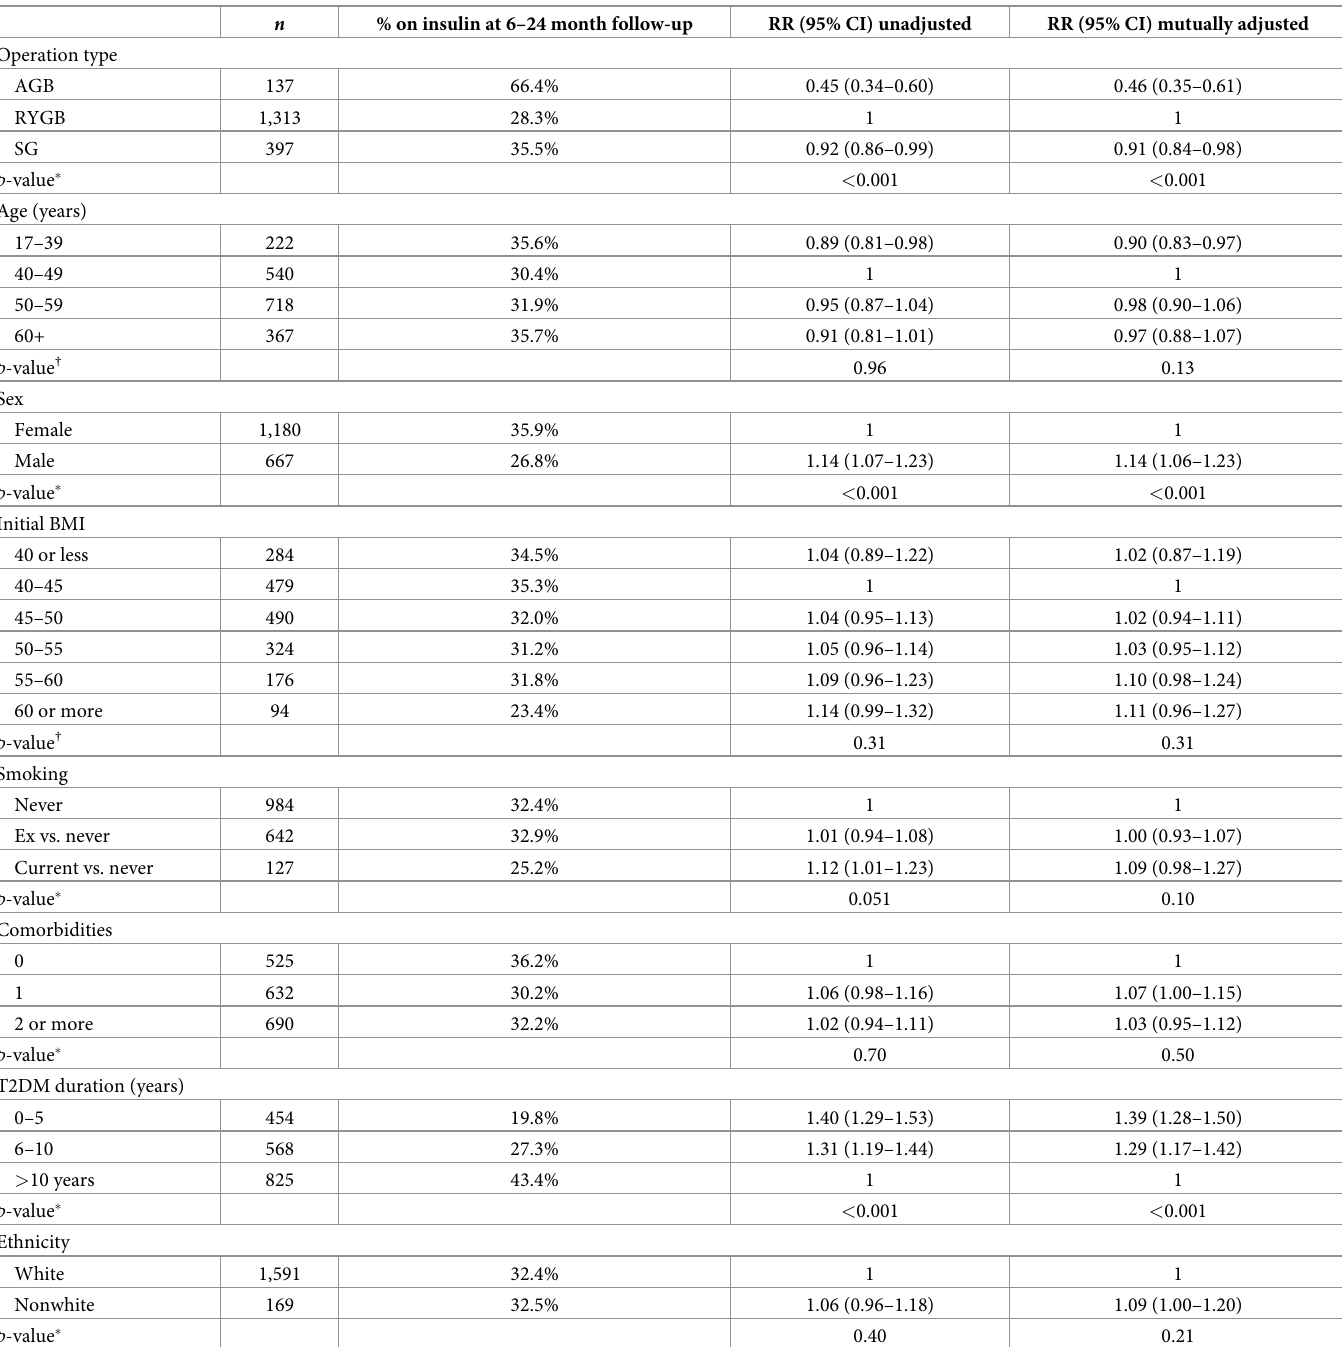
Table 4. Unadjusted and adjusted RRs for insulin cessation at follow-up by baseline factors ( n =